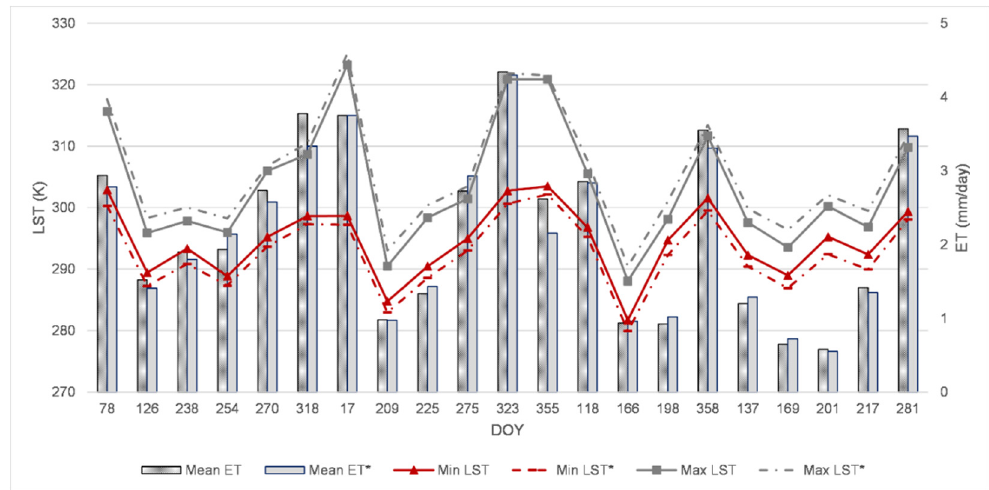
Figure 8. Minimum and Maximum Land Surface Temperature (Kelvin) and Mean daily evapotranspiration (mm/day) of the entire study area. * without noise on Land Surface Temperature.